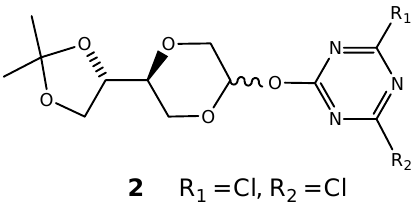
Figure 4. Triazine nucleoside